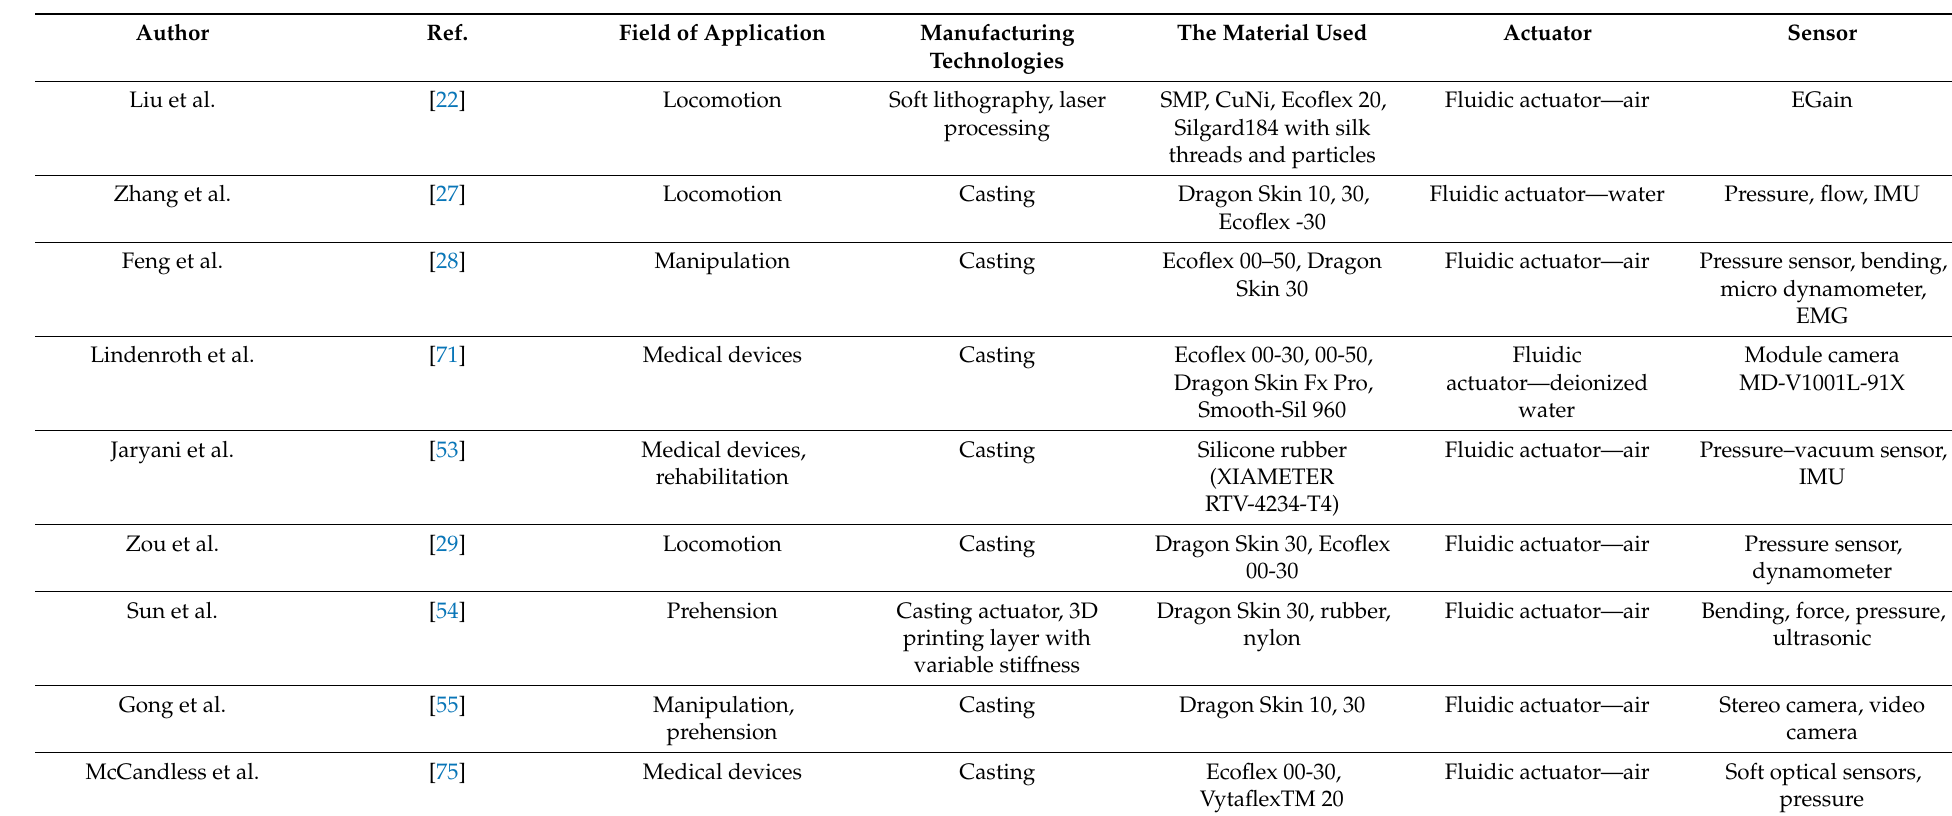
Table A1. General analysis of bibliographic